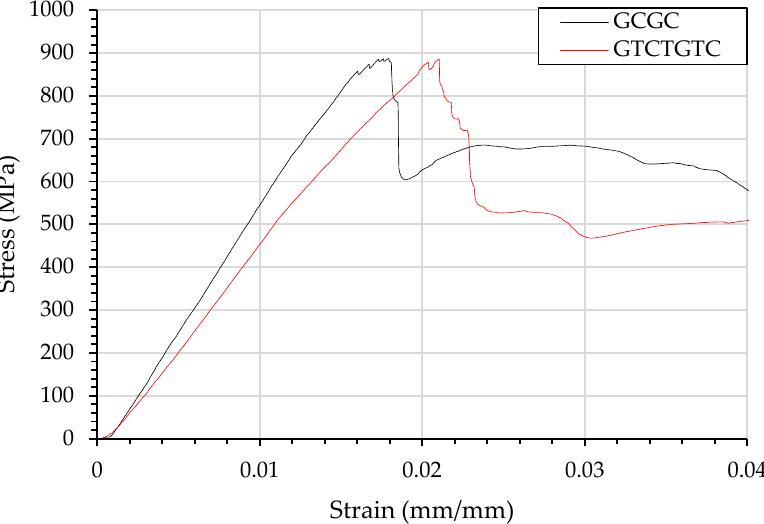
Figure 12. Flexural testing using three-point bending of composites beams and resulting stress strain curve of GCGC and GTCTGTC.